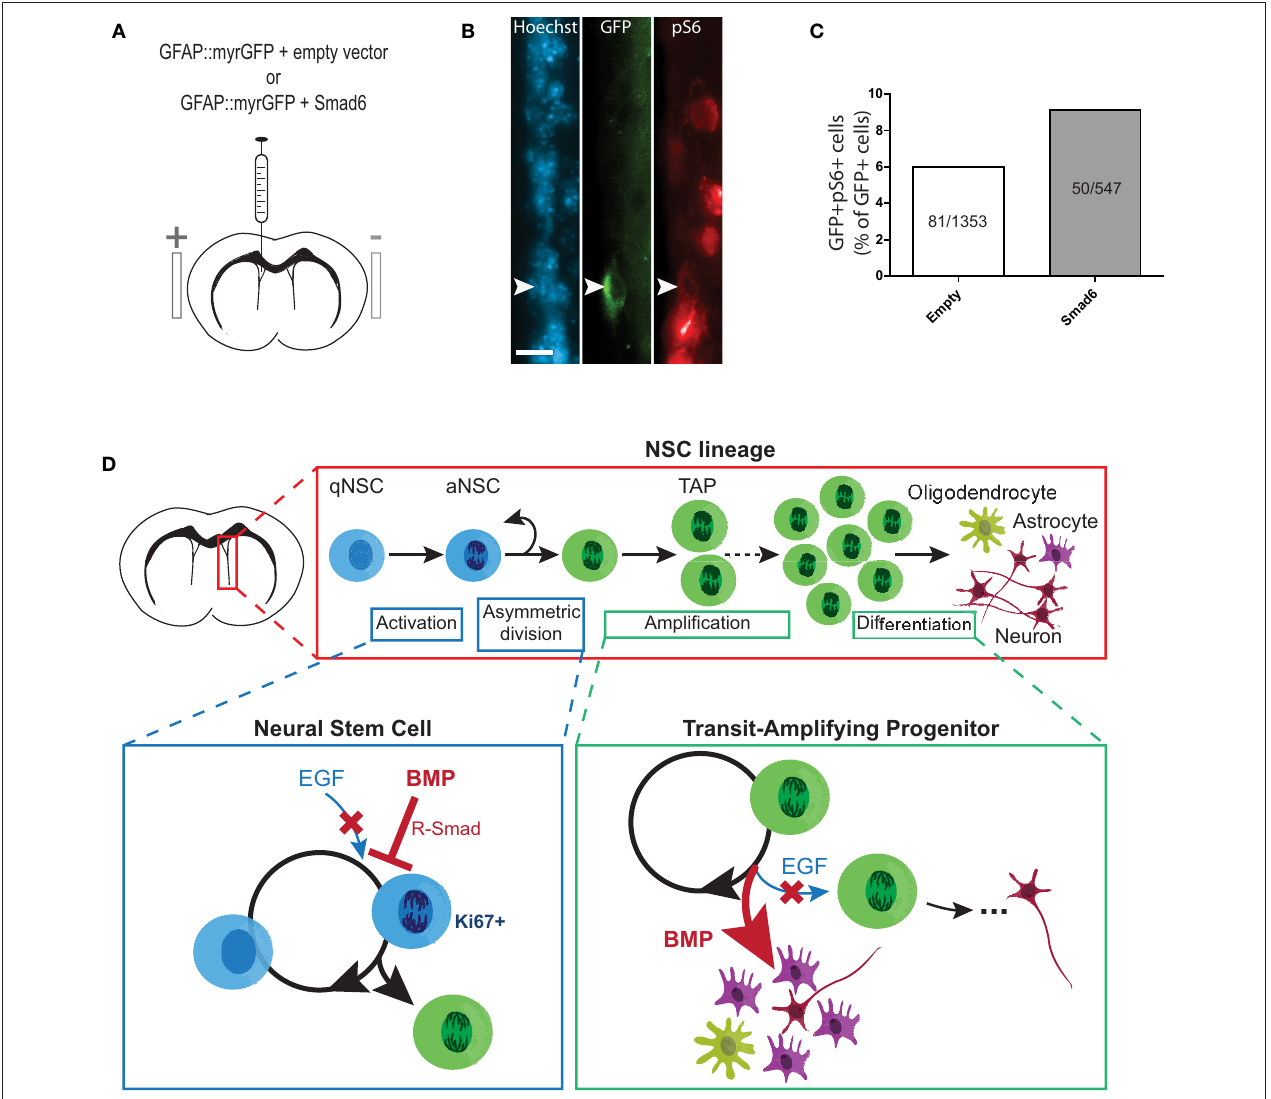
FIGURE 6 | Inhibition of BMP-SMAD signaling in NSCs promotes mTORC1 activity in vivo . (A–C) In vivo electroporation of SMAD6 upregulates mTORC1 signaling in quiescent GFAP-positive NSCs. Experimental paradigm of in vivo adult brain electroporation (see Materials and Methods for details) (A) . Representative immunofluorescence images of GFAP::myrGFP-expressing NSCs that were double-labeled with pS6 (B) . Counts of GFAP::myrGFP cells that were double-labeled with pS6 (data pooled from N = 7 − 8 per group) (C) . (D) Summary figure: EGF-induced proliferative expansion of TAPs is dominantly suppressed by BMP via distinct stage-specific mechanisms. (Top) The majority of NSCs in the SVZ niche are quiescent. Upon EGF receptor (EGFR) activation, an NSC divides asymmetrically to generate a TAP, which undergoes several rounds of proliferative expansion before generating differentiated neural progeny (under normal conditions, predominantly neurons). (Lower left) At the NSC stage, ligand-induced stimulation of EGFR promotes NSC activation to generate a TAP via asymmetric division. BMP-induced activation of receptor-regulated SMAD (R-SMAD) dominantly inhibits EGFR-mediated NSC activation to promote NSC quiescence. (Lower right) At the TAP stage, EGFR stimulation promotes proliferative expansion of TAPs. BMP dominantly inhibits EGFR-mediated TAP proliferation and promotes astrocytic differentiation. Thus, increased BMP signaling in the SVZ leads depletes the TAP population by promoting quiescence of upstream NSCs and differentiation of TAPs. Scale bar (B) = 25